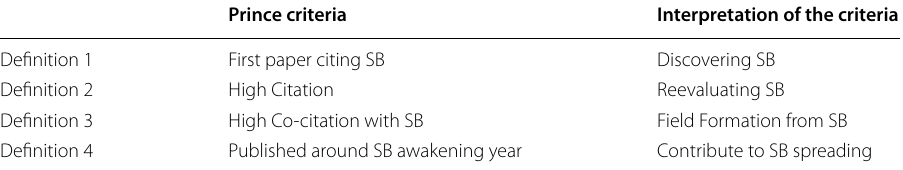
Table 9 Prince criteria and interpretation Prince